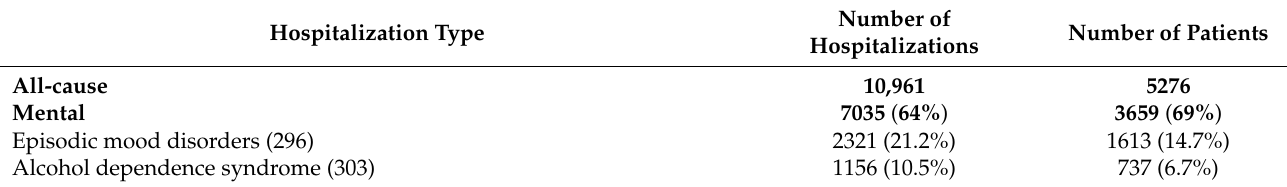
Table 3. Number of hospitalizations and patients by hospitalization